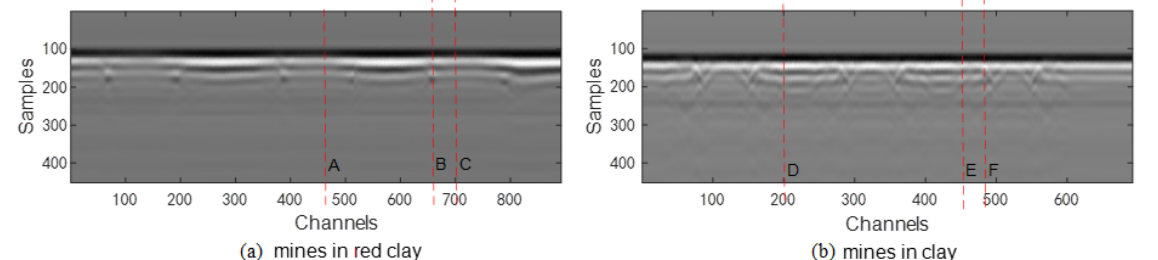
Figure 14. The detection data of mines in red clay and clay. (The channel numbers of A–F are 461, 659, 701, 200, 449, and 483, respectively.).